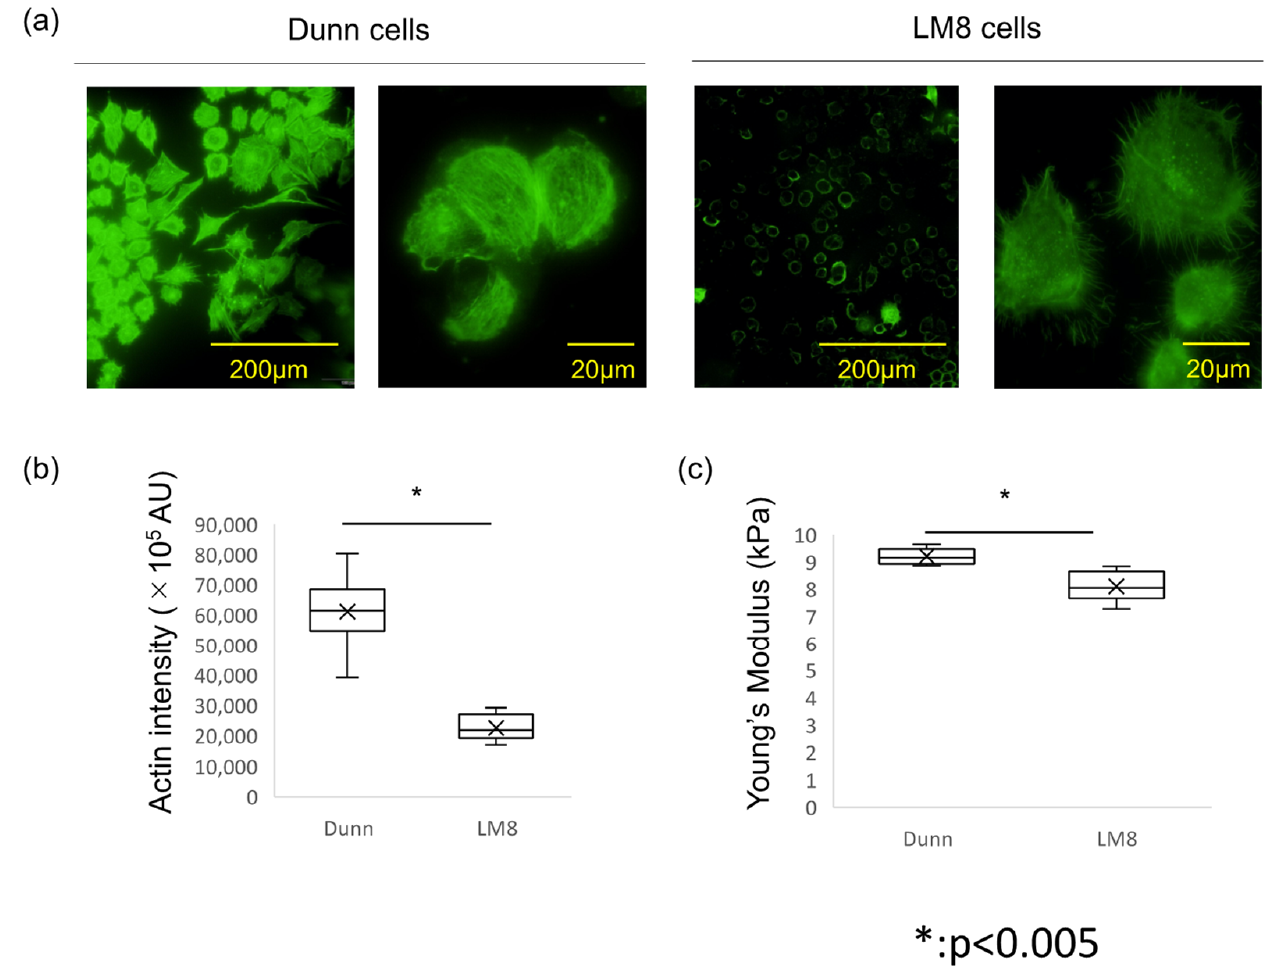
Figure 2. Actin polymerization, intensity, and stiffness between Dunn and LM8. ( a ) Actin cytoskeleton was stained with Alexa 488-conjugated phalloidin. Left : Dunn, Right : LM8. ( b ) Actin staining intensity was evaluated by arbitrary units (AU) using Image J software. * p < 0.005. ( c ) Young’s modulus was measured by AFM. Mean ± SD, Dunn: 9.20 ± 0.27 kPa. LM8: 8.11 ± 0.51 kPa. * p < 0.005.